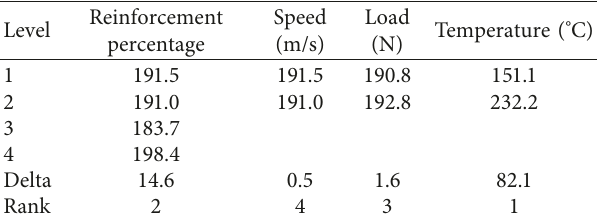
Figure 5: Interaction impact of various process parameters on COF of AA7050/Al2O3 composites. Table 4: ANOVA for altered process